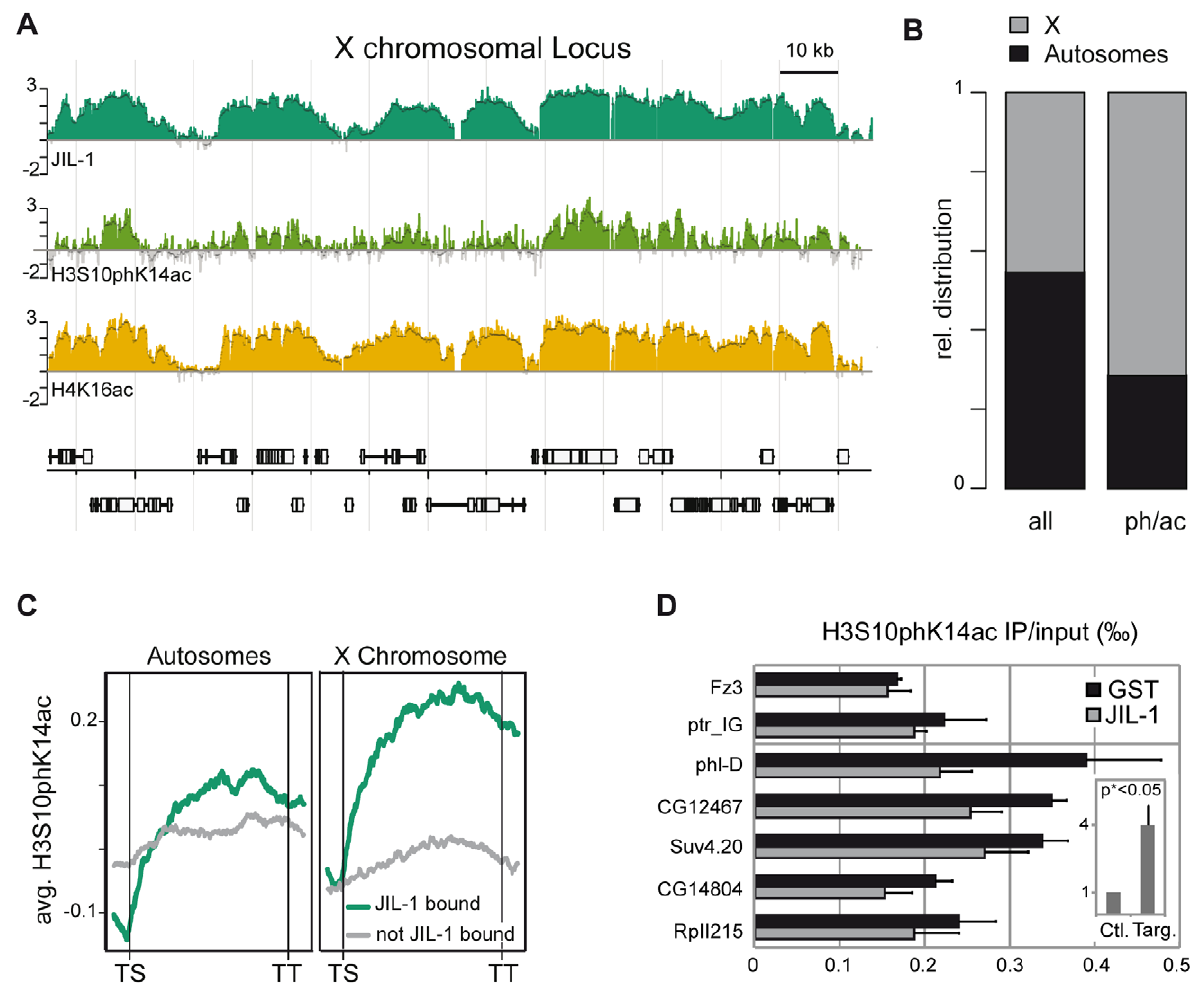
Figure 3. JIL-1–dependent H3S10phK14ac is enriched on the compensated X chromosome together with JIL-1. (A) Genome-wide distribution of H3S10phK14ac in comparison to JIL-1 and H4K16ac on a 140 kb X-chromosomal locus close to the gene phl. (B) Fractional distribution of probes significantly enriched for H3S10phK14ac (n=4478) with respect to chromosomal location. As a comparison, the distribution of all probes (n=384680) represented on the array is shown. (C) Cumulative binding profiles of H3S10phK14ac along genes that are either bound (n=3362) or not bound (n=2050) by JIL-1. (D) Decrease of H3S10phK14ac ChIP signal at the 3 9 end of the genes phl , CG12467 , Suv4.20 , CG14804 and RpII215 after JIL-1 RNAi as compared to a control GST RNAi. The intergenic region close to ptr and the inactive gene Fz3 are shown as negative control regions. Results are the mean of 3 biological replicates and error bars represent the standard error of the mean. In the insert, we showed that the difference of the H3S10phK14ac ChIP signal after JIL-1 depletion is 4 times higher for target loci compared to control loci after normalization. This difference is statistically significant since the 2-sided unpaired t-test applied to the data gave a p value , 0.05. doi:10.1371/journal.pgen.1001327.g003 upper panels). The distribution of ePol along the transcribed transcription level. This was also observed for H3K36me3 and regions is similar for autosomal and X-linked genes with a modest MSL1 distributions using the same representations (Figure S3C, S3D; Figure S8B, S8C) whereas the density of H3K4me2 and ePol enrichment towards the 3 9 end. Monitoring the binding of JIL-1 were roughly proportional (Figure S8D). The discordance between along the gene bodies as a function of ePol density, we found that ePol and JIL-1 distributions along gene bodies was even more while JIL-1 clearly associated with active genes, its binding was not pronounced when monitored as a function of gene length proportional to ePol levels (Figure 5A centre panels). Rather, three (Figure 5B). On autosomes, ePol was found enriched towards out of the four groups with significant association of ePol showed the same average binding of JIL-1, except that there was roughly the 3 9 end of short genes, but for genes longer than 1.8 kb the twice as much JIL-1 on X-chromosomal genes compared to maximal density of ePol gradually shifted towards their 5 9 ends as autosomal genes, as observed before. This property was also a function of length. This is also illustrated by visual inspection of illustrated when the density per gene was plotted against the very long genes both on the X and on autosomes (Figure S9). It is corresponding steady-state transcript levels. Whereas the ePol conceivable that the risk of premature transcription termination increases with gene length and thus leads to relative depletion of density and transcript levels correlated well, JIL-1 binding was ePol at 3 9 ends. Interestingly, this trend was less pronounced on characterized by two clouds representing autosomal and X the X chromosome, in keeping with the attractive hypothesis that chromosomal genes (Figure S3B). These two representations show that the density of JIL-1 on active genes is not proportional to their dosage compensation facilitates transcriptional elongation through